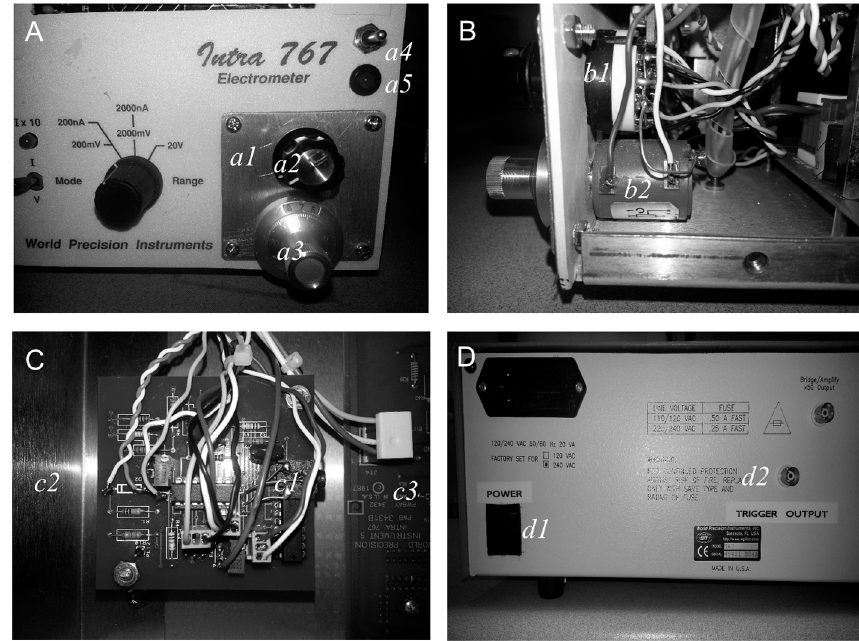
Figure 2. WPI electrometer panel modifications. ( A ), The front panel power switch has been removed and fixed to the back panel of the instrument. In its place is an aluminium panel ( a1 ) onto which is fixed the 10-turn (10k) potentiometer ( a2 ) and 6-position function switch (SW2A,B; a3 ). The power switch (SW1; a4 ) and the LED monitor ( a5 ) are mounted to the right of the panel. ( B ), Side-on view of the 10-turn potentiometer ( b1 ) and the function switch ( b3 ). ( C ), Pulser printed circuit board (PCB) ( c1 ) mounted inside the WPI Intra 767 case between power supply section at left ( c2 ; not shown) and main circuit board ( c3 ). Note that this is a working prototype but is not the final PCB design available in the Supplementary files.( D ), Rear panel showing new location of main power switch ( d1 ) and trigger output connector ( d2 ). LED = Light Emitting Diode.